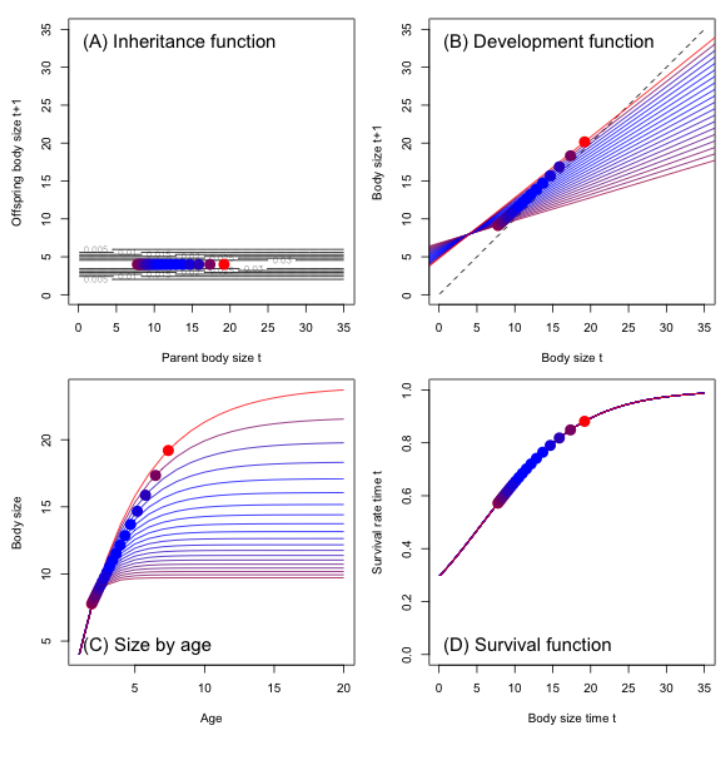
Figure 1. Density-independent functions in the density-dependent reproduction scenario. (A) association between parental size at time t and offspring size at time t + 1 , where the black lines are contours representing the probability distributions of offspring sizes, (B) development functions, where contours representing the probability distribution of sizes at t+1 are not shown, (C) monomolecular growth functions showing size as a function of age, (D) mean of the body size-survival function. Unlike in A) we do not show the contours of the probability distributions. Each line represents one of the 20 life histories, and each dot represents size (or age in the case of C) at sexual maturity. The redder the colour of a point, the fitter the life history strategy (i.e., greater carrying